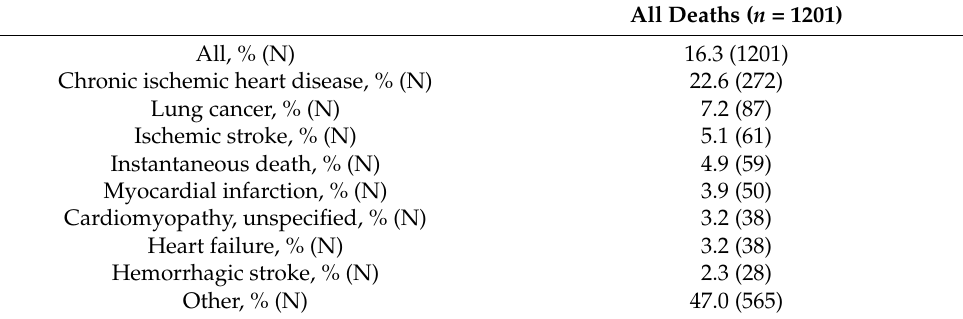
Table 2. Most common causes of death in the overall study population ( n =